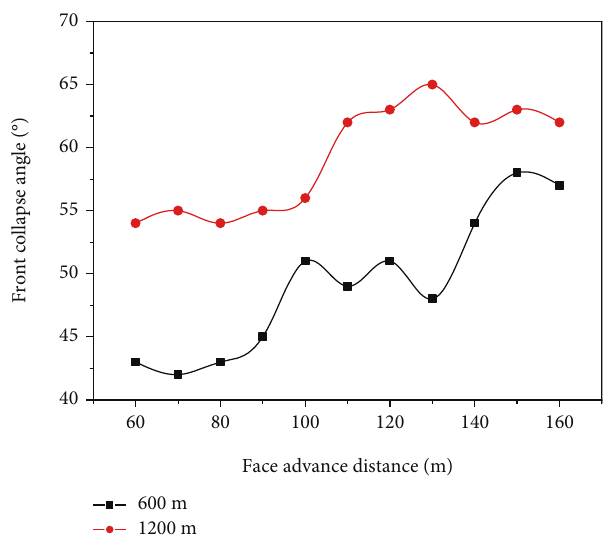
Figure 11: Change regulation of the height of two zones in di ff erent advancing distances of 600 m and 1200m mining depth.